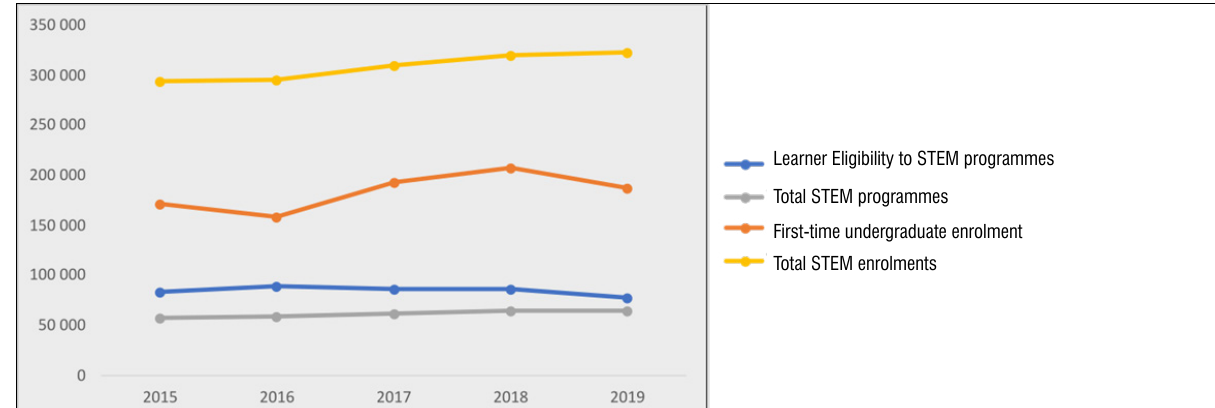
Figure 3: Trends of learner eligibility for STEM programmes, first-time undergraduate enrolment, and overall STEM enrolments for